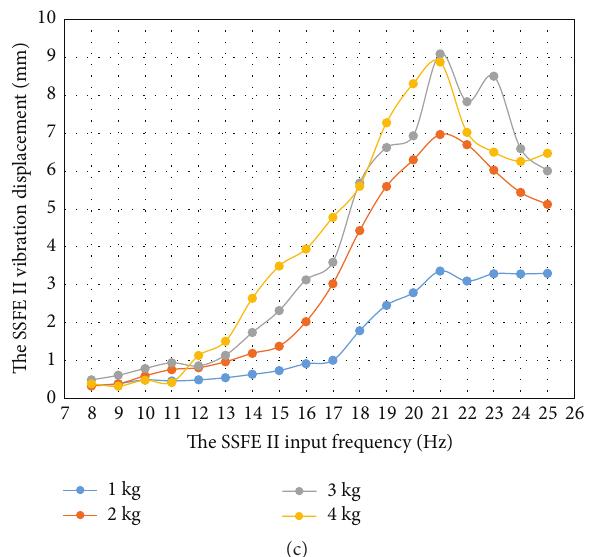
Figure 18: Along every direction, curves of the SSFE II vibration displacements changing with the SSFE II input frequency under different eccentric masses. (a) Along the x axis. (b) Along the y axis. (c) Along the z axis.